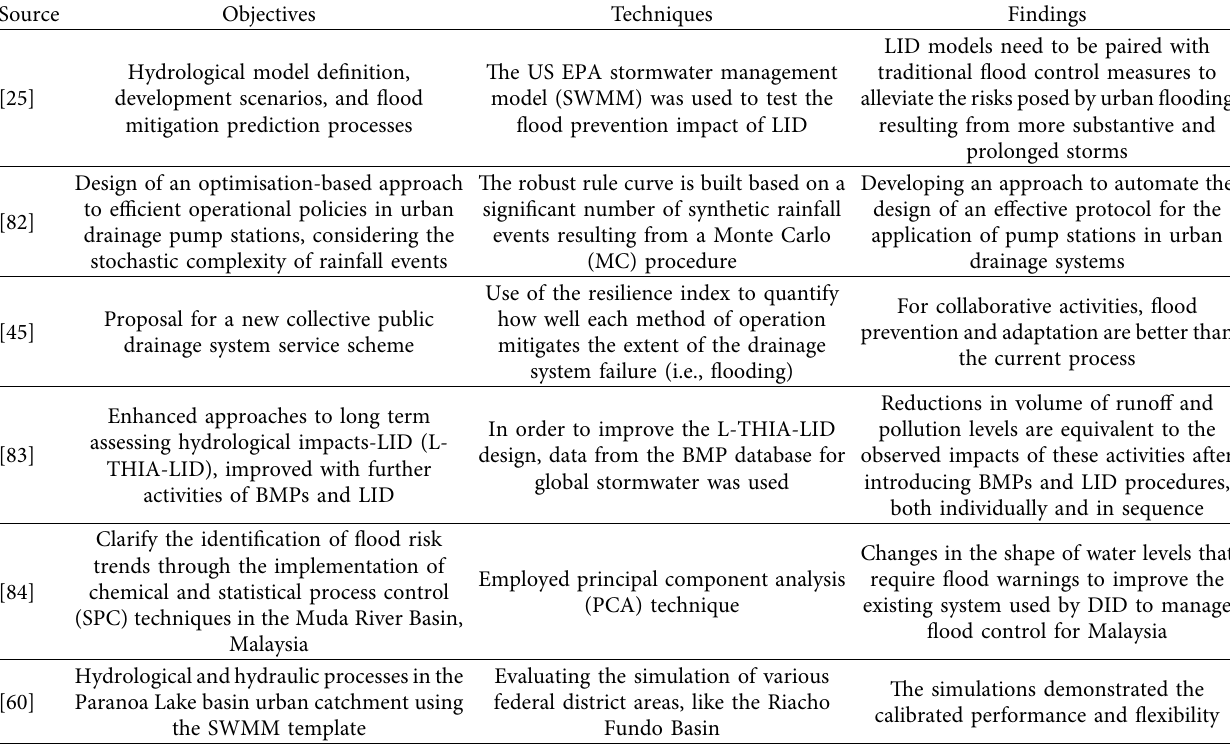
Table 2: Techniques to optimise the performance of road stormwater drainage